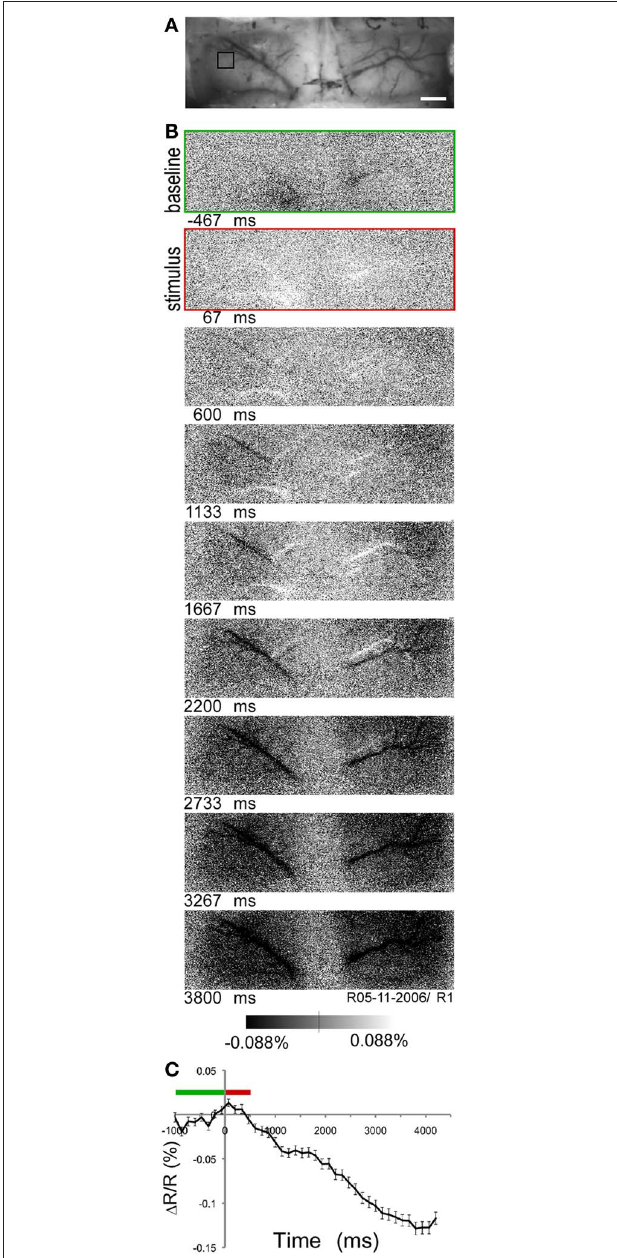
FIGURE 3 | Intrinsic optical imaging of rat visual cortex. (A) Image taken under green (540nm) light to visualize vasculature over visual cortex through thinned skull. Scale bar, 1mm. (B) Time series of intrinsic images taken at 7Hz under orange (605nm) light. First image, baseline period (green); second image, visual stimulation period (red) (C) Time course (mean ± standard error) of intrinsic signal in region of interest indicated in (A, black square). Green bar, baseline period; red bar, stimulation period (stimulus onset at time 0).